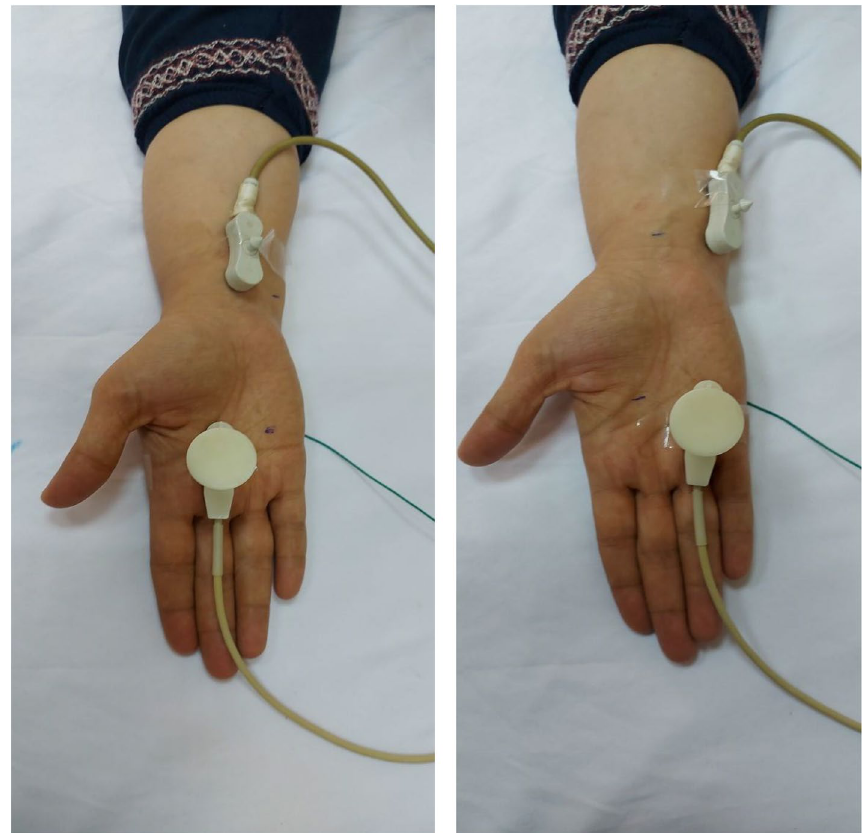
Fig. 1 Control group at the left showed normal neurophysiological parameters of median, ulnar motor, and sensory studies; normal 4 comparative tests. CTS group at the right showed normal neurophysiological parameters of median, ulnar motor, and sensory studies; abnormal LM‑IN (> 0.5); abnormal MVR (>0.4); abnormal Mix U‑M (>0.4); and normal MVU ( 0.5). The traces from above downwards [median motor wrist, elbow, and palm ≤ (control only), LM‑IN (2 traces), routine median sensory, MVR(2 traces), Mix M‑U (2 traces), routine ulnar sensory, and MVU (last 2 traces)